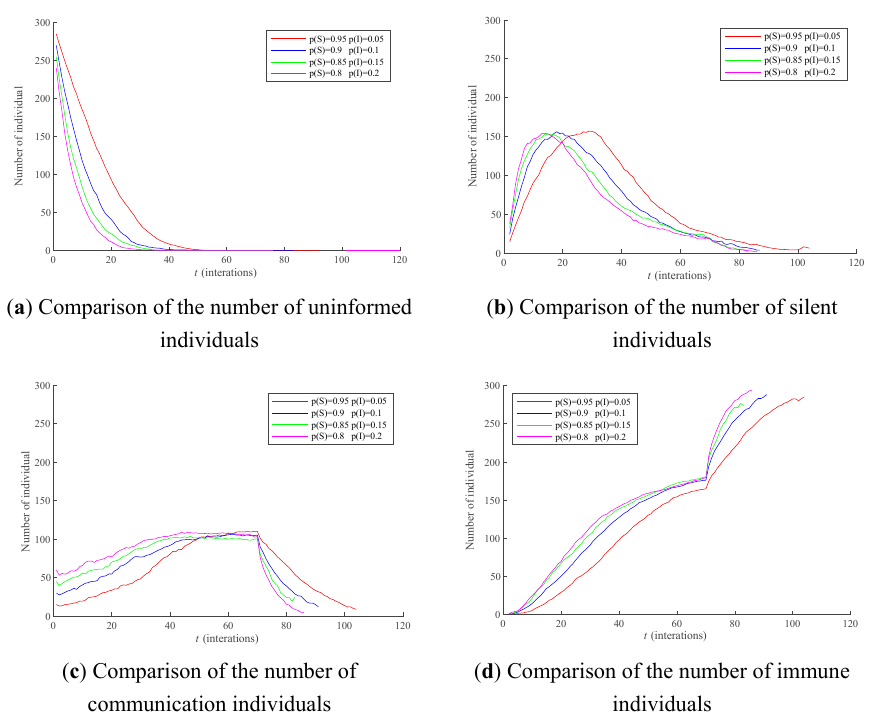
Figure 6. The influence of different proportions of communication individuals at the initial moment on the dissemination process of public opinion. Notes: ( a ) Comparison of the number of uninformed individuals, ( b ) Comparison of the number of silent individuals, ( c ) Comparison of the number of communication individuals, ( d ) Comparison of the number of immune